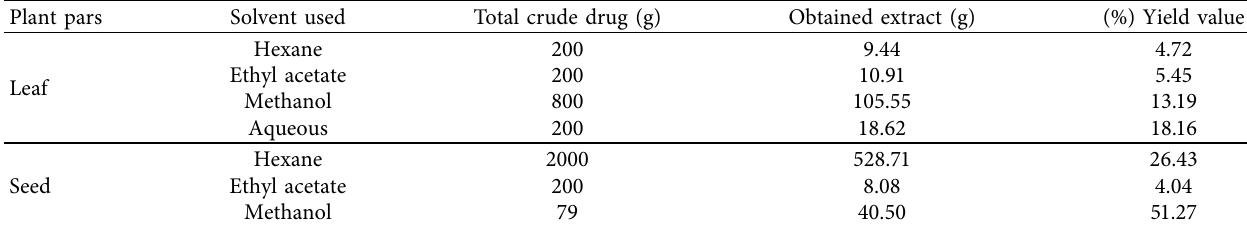
Table 1: Percentage yield value from different crude extracts of P. utilis leaf and seed. Plant